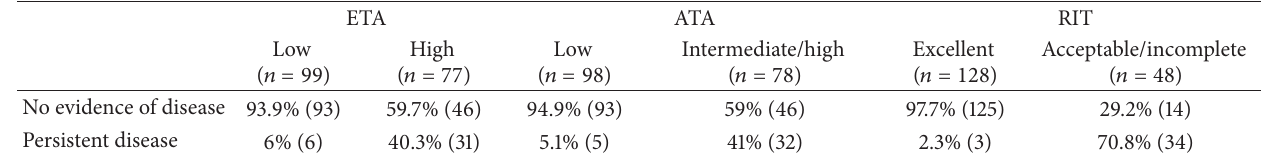
Table 4: 2 × 2 contingency tables for each risk stratification system.